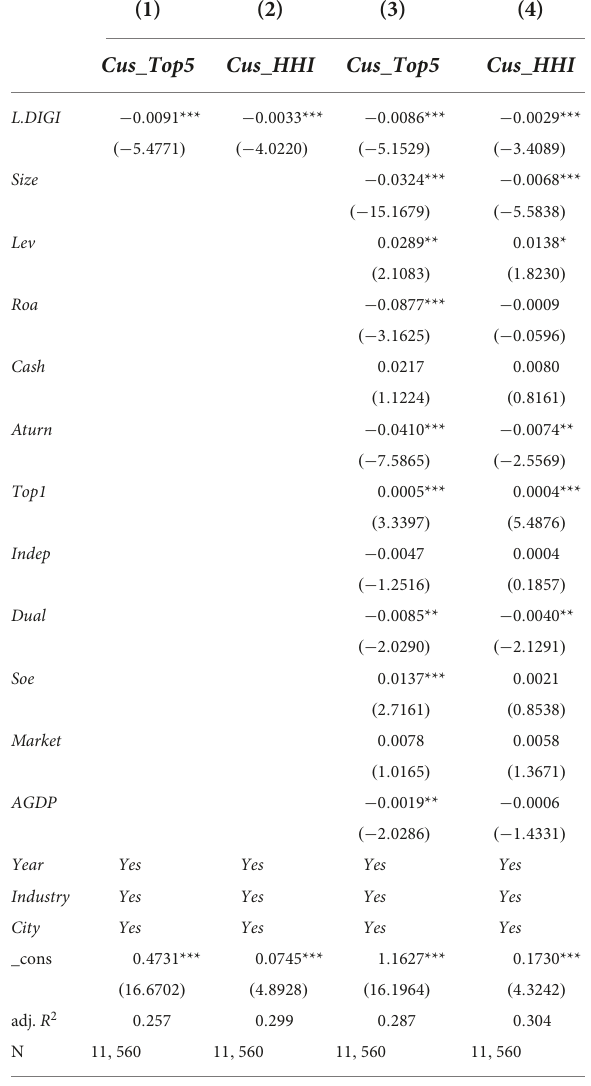
TABLE 4 Enterprise digital transformation and customer